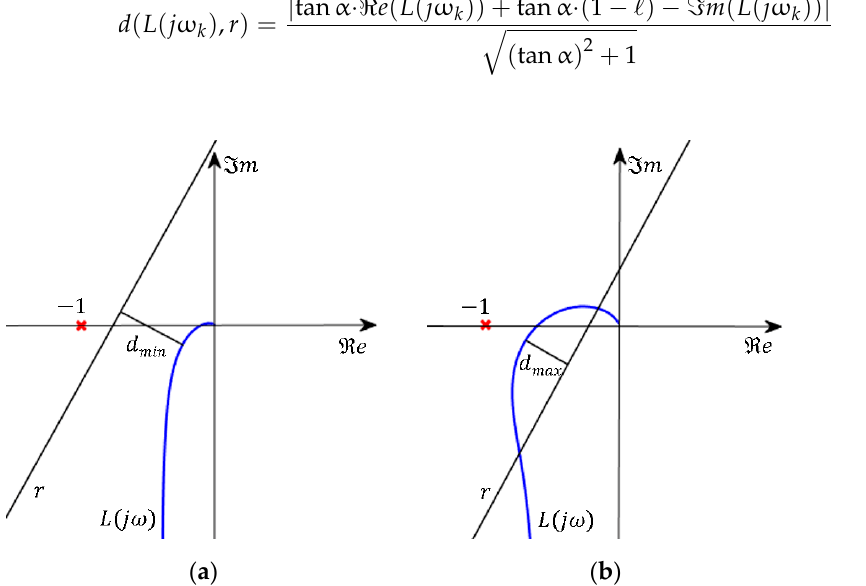
Figure 7. Different cases evaluating the linear margin and determining the fitting distance of the Nyquist plot L( j ω ) to the line r : ( a ) all points of L( j ω ) are below the line r and ( b ) some points of L( j ω ) are above line r .